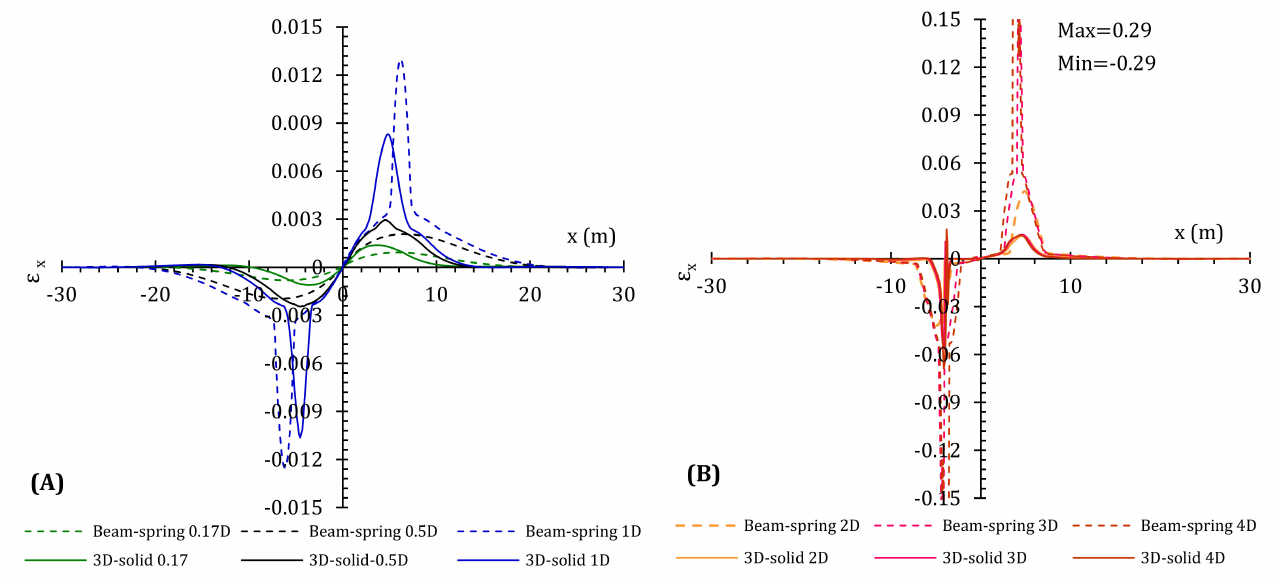
Figure 17. Maximum/minimum longitudinal strain of a buried pipeline subjected to a 60 ◦ strike-slip fault, 3D solid model versus beam–spring model. ( A ) Cases with a 0.17D to 1D fault movement; ( B ) cases with a 1D to 4D fault